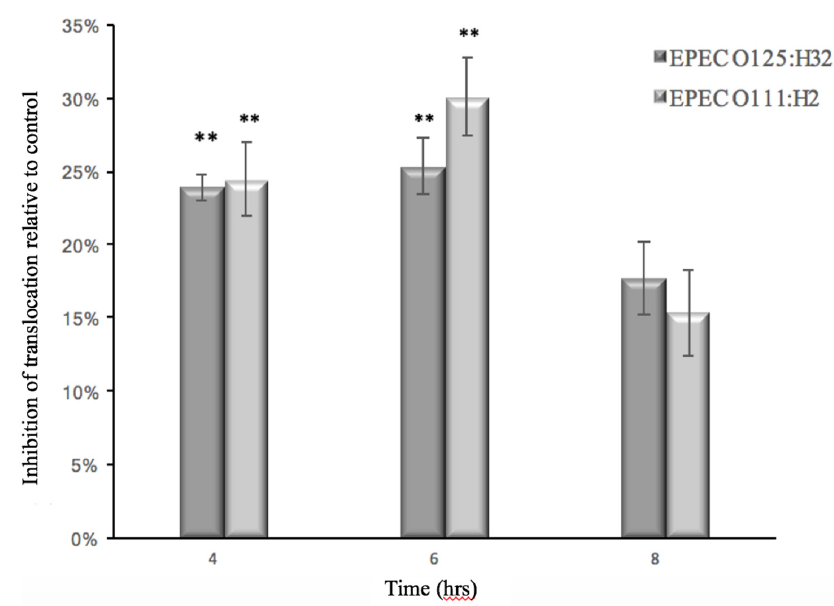
Figure 4. Percentage reduction of E. coli translocation across Caco-2 monolayers when pretreated with GMP in comparison to untreated control (** p < 0.01).